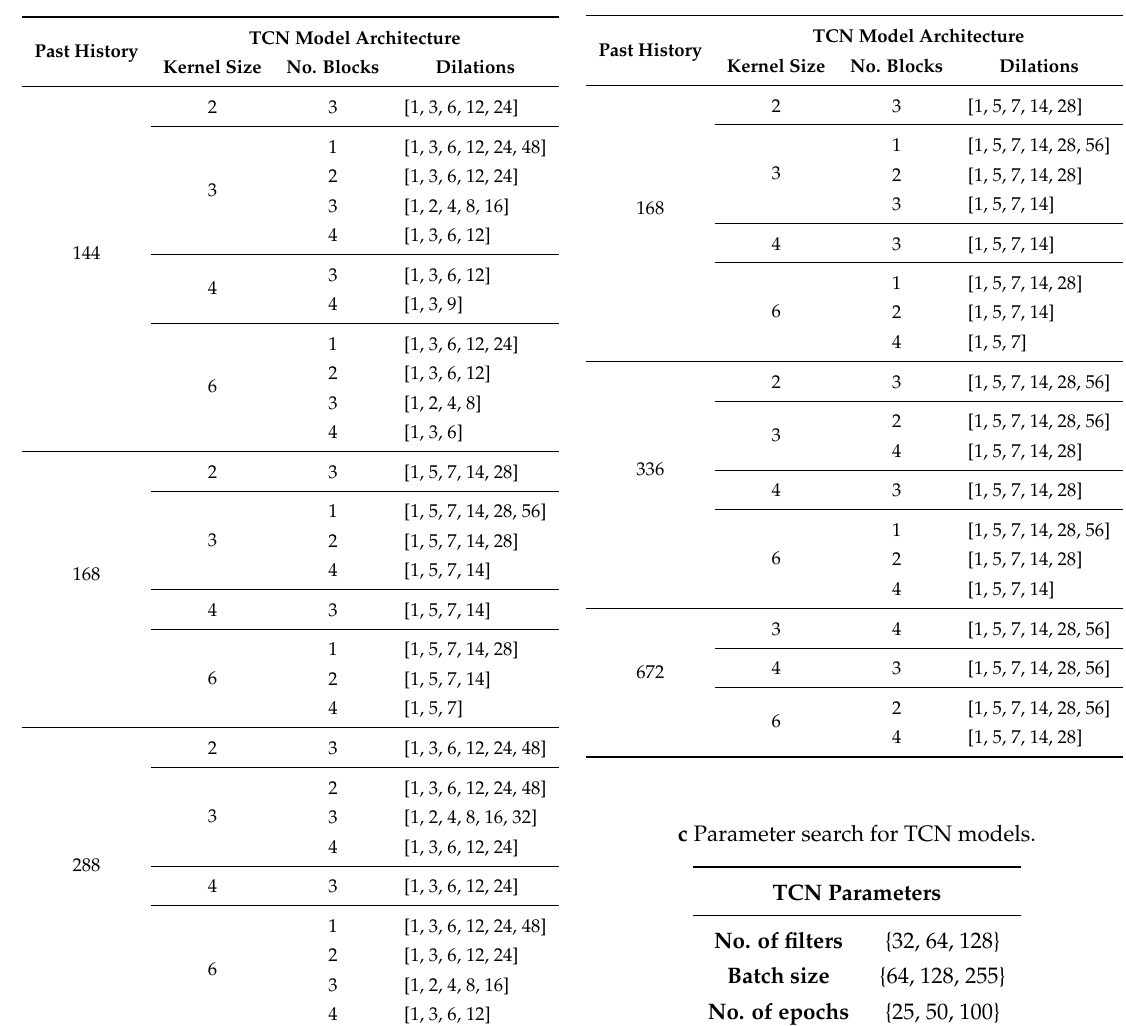
Table 1. Architecture configuration of all TCN models for each dataset and common parameter search. a TCN architectures depending on the past history for electric demand